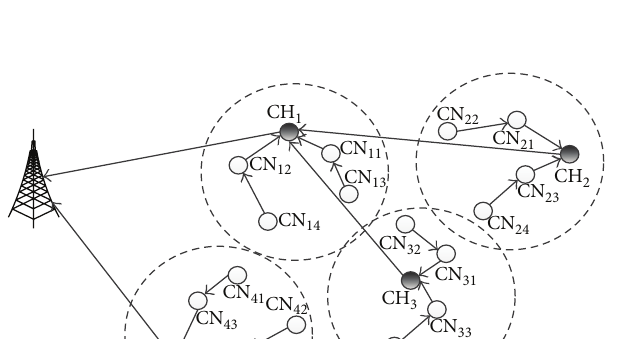
Figure 2: Locating mechanism.